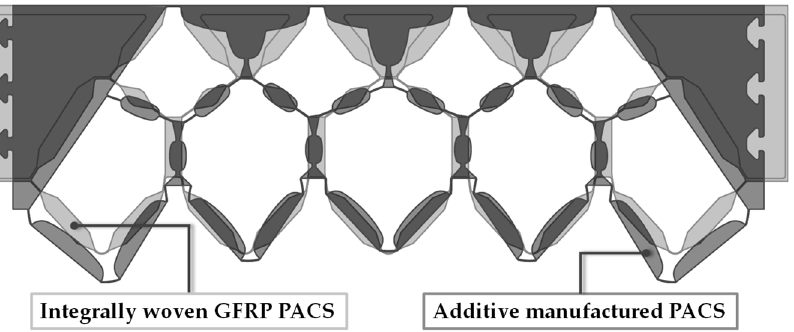
Figure 17. Comparison of two PACS cross-sectional designs: “CS-AM” optimized for additive manufacturing; “CS-FRP” adapted to restrictions from integral woven GFRP manufacturing.